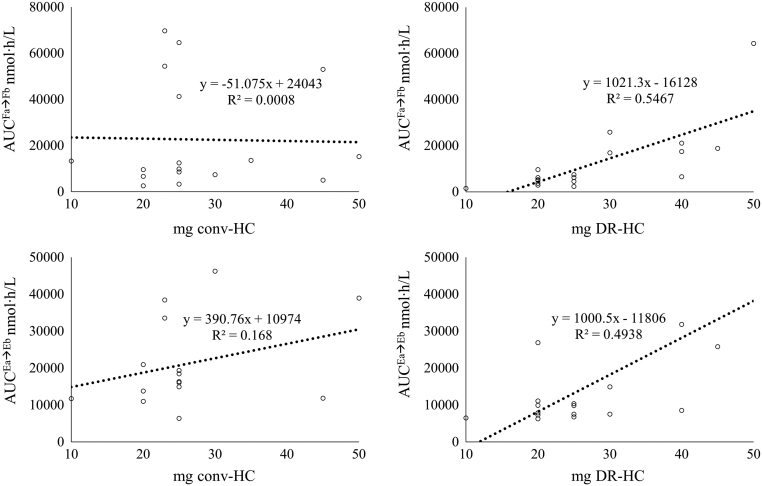
Linear regression (black dotted line) among cortisol or cortisone daily exposure (in term of AUC) and GC dose. Each dot represents a patient.